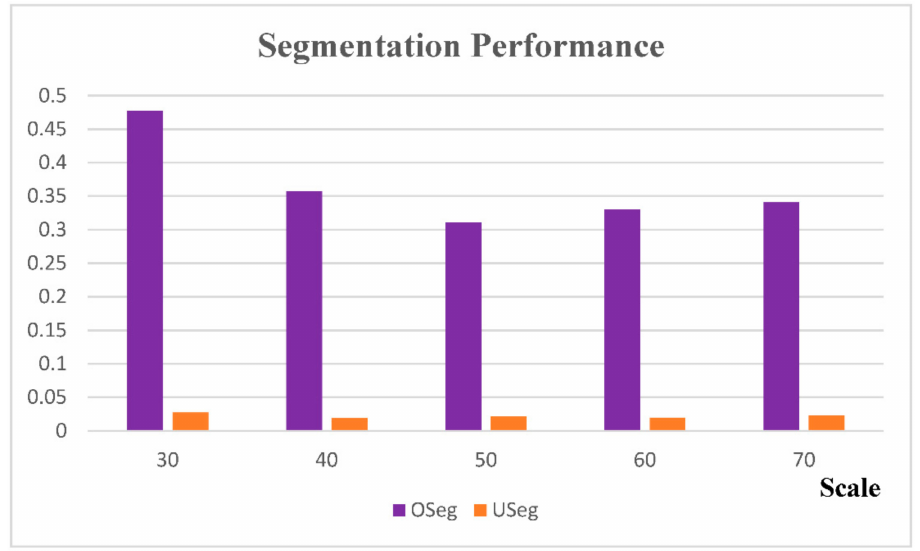
Figure 6. Quantitative evaluations of segmentations at different scales for